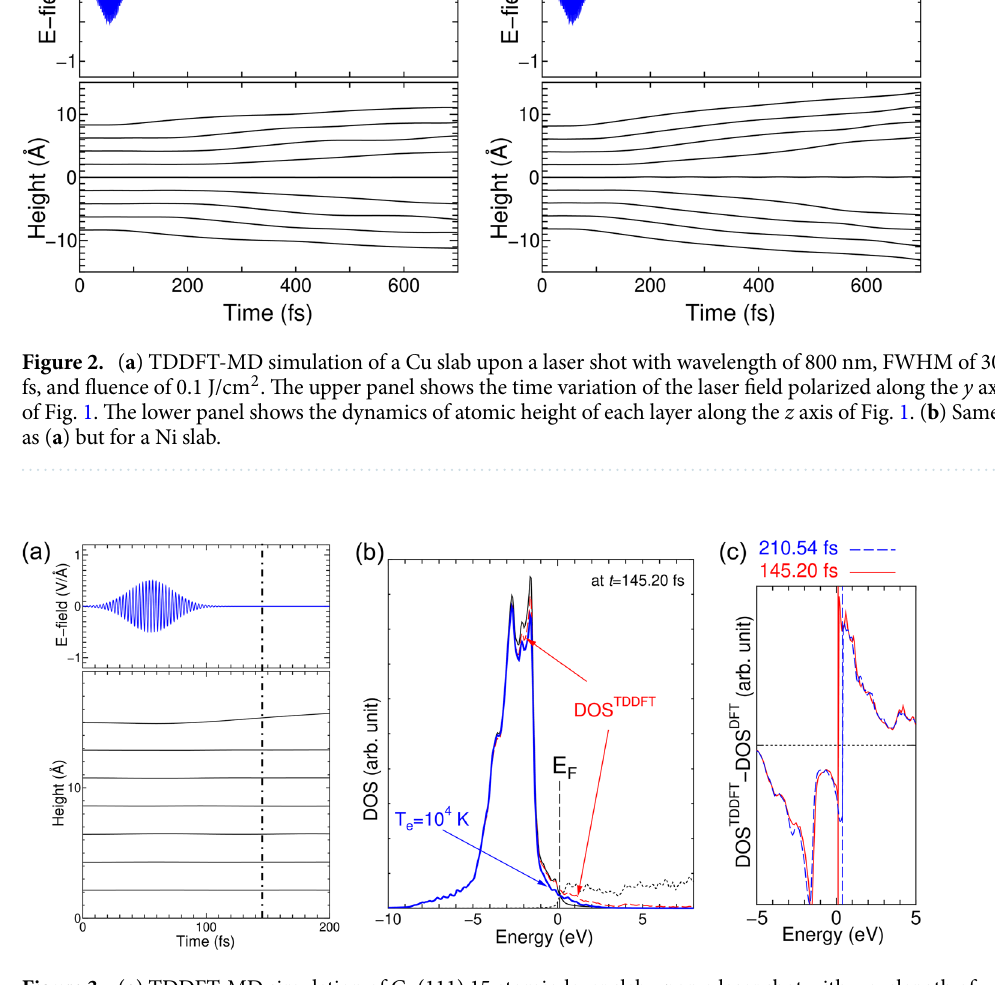
Figure 3a shows a TDDFT-MD simulation under the laser shot. The lattice expansion starts around 110 fs, at which point the laser field decays. The simulation is up to 200 fs and the dynamics of each layer is very similar to those of 9-layer slab as displayed in Fig. 2a. Meanwhile, Fig. 3b shows the DOS obtained by TDDFT-MD TDDFT ( r , t ) onto the Kohn-Sham orbitals ψ DFT ( r ) simulation (DOS TDDFT ) at t = 145.20 fs by projecting the ψ n, k n, k obtained by the static DFT simulation with atomic coordinates the same as at the snapshot ( t = 145.20 fs) of the TDDFT-MD simulation. (For numerical details, see Sec. S.III of the supplementary materials.) The high DOS peaks below the Fermi Level (E F ) (0 eV) in Fig. 3b match the flat-dispersion region of the band structure of bulk Cu, see red arrows indicated in Fig. S.1a in the supplementary materials of this manuscript. The lower (higher) DOS TDDFT compared with the DOS by DFT simulation (DOS DFT ) in the valence (conduction) band region denotes the creation of holes in valence bands (creation of electrons in conduction bands).